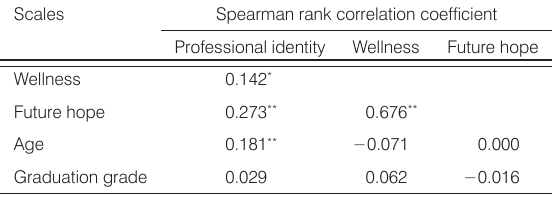
Table 6. Correlation matrix of professional identity, wellness, and future hope scales scores and nurse interns’ age and graduation